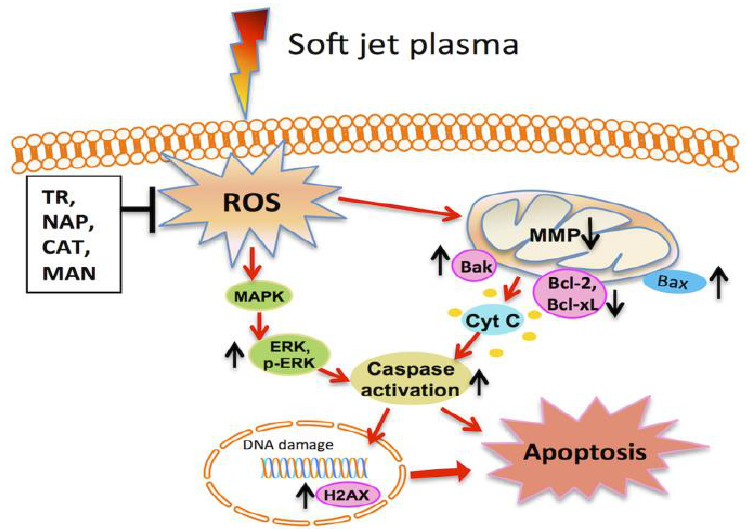
Figure 4. Molecular mechanism of soft-jet plasma-induced cancer cell apoptosis via the mitochondrial intrinsic pathway and extracellular signal-regulated kinase / mitogen-activated protein kinase (ERK / MAPK) activation